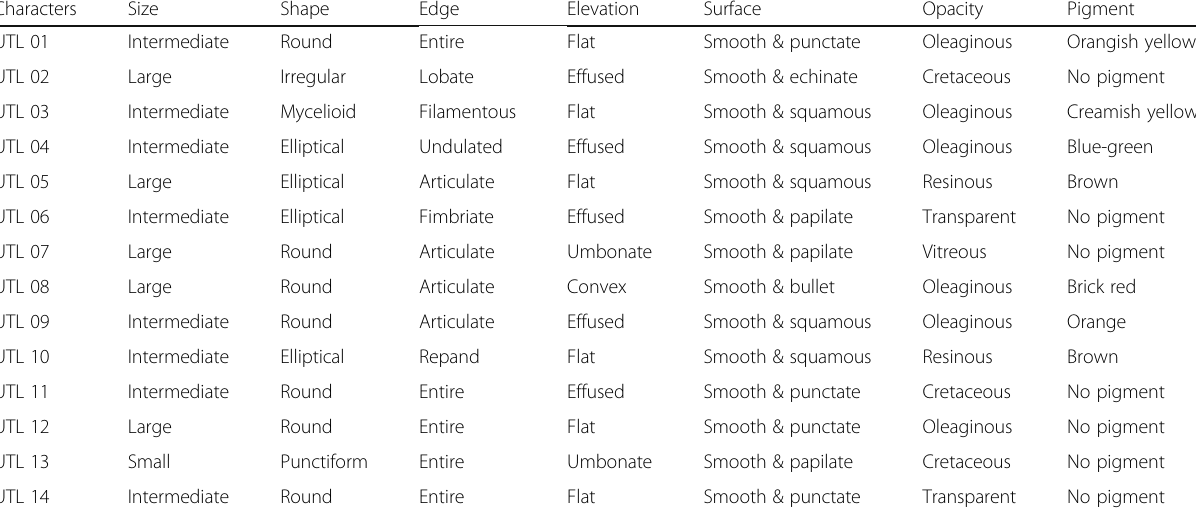
Table 1 Colonial character of bacterial isolates from unused leech saliva Characters